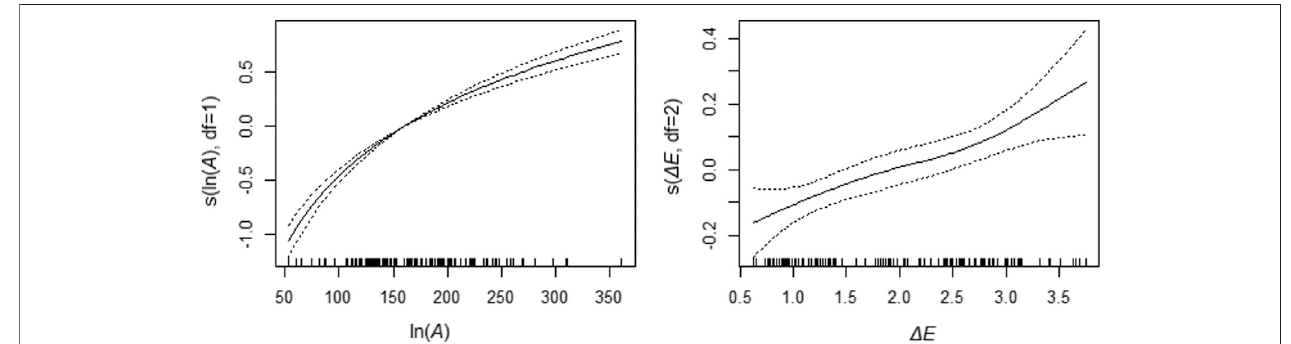
FIGURE 5 | Model 15 partial residual plots.